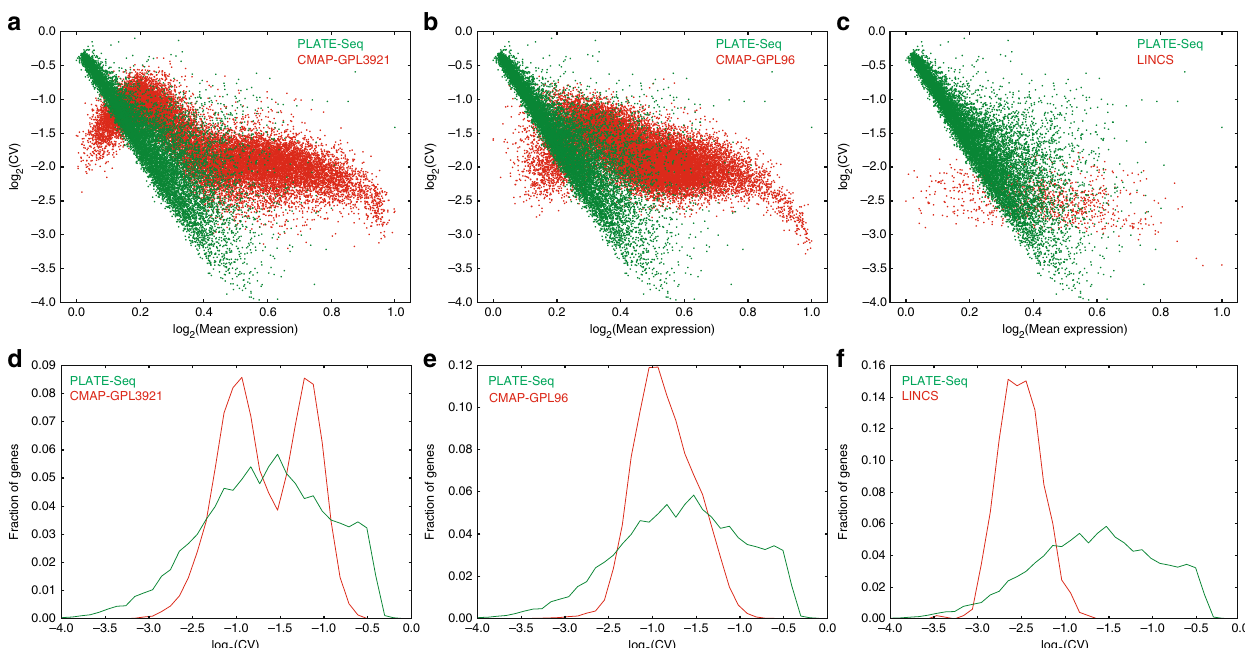
Fig. 3 Comparison of PLATE-Seq to CMap and LINCS. a Mean CV vs. relative mean expression for PLATE-Seq U87 184-compound screen and CMap GPL3921 microarray platform duplicates. b Same as a for PLATE-Seq U87 screen and CMap GPL96 microarray platform. c Same as a for PLATE-Seq U87 screen and LINCS/L1000 screen. d CV histogram across genes for duplicates in the PLATE-Seq U87 screen and CMap GPL3921 microarray platform. e Same as d for PLATE-Seq U87 screen and CMap GPL96 microarray platform. f Same as d for PLATE-Seq U87 screen and LINCS/L1000